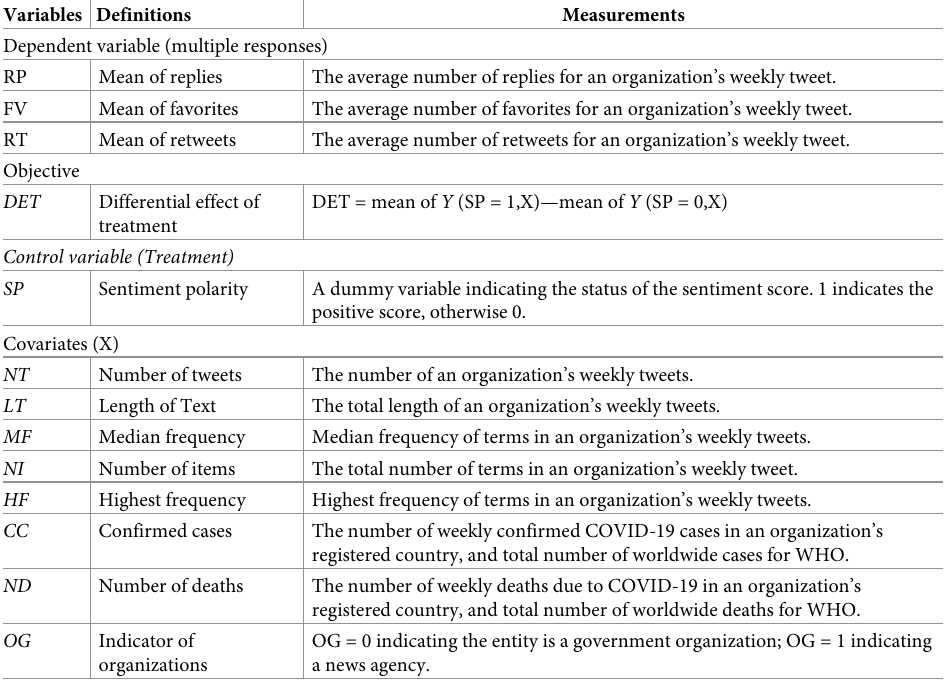
Table 2. Variable definitions and